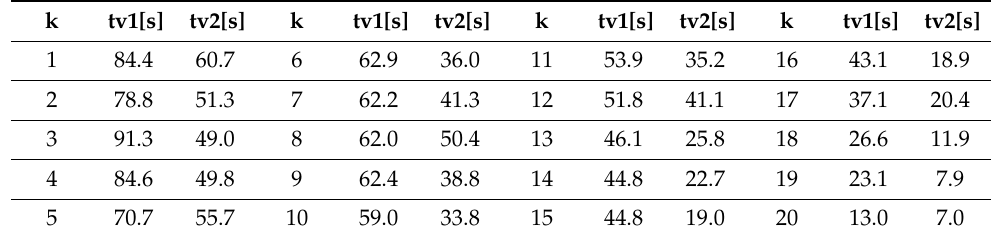
Table 9. Execution time for the two